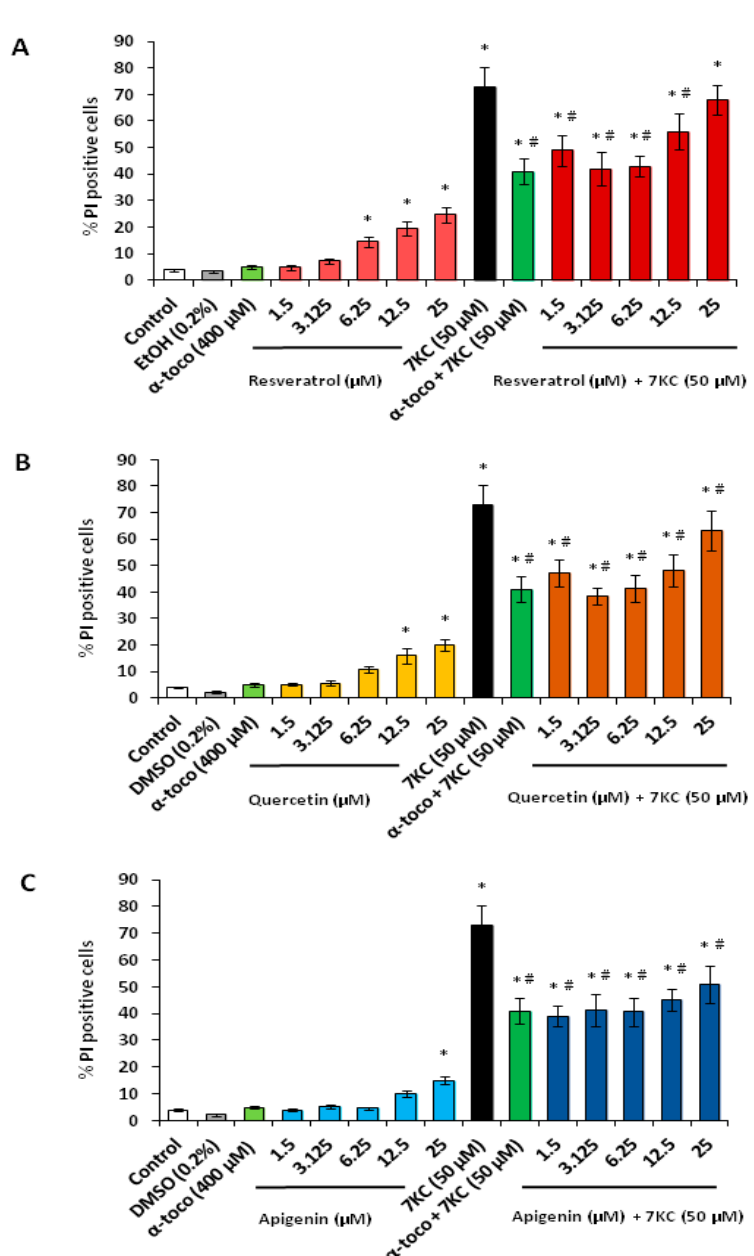
Figure 2. E ff ects of resveratrol, quercetin, apigenin or α -tocopherol on 7-ketocholesterol-induced plasma membrane permeability evaluated with propidium iodide. N2a cells were cultured for 48 h with or without 7-ketocholesterol (7KC, 50 µ M) in the presence or absence of α -tocopherol ( α -toco: 400 µ M) used as the positive control for cytoprotection, or with polyphenols: resveratrol (RSV) ( A ), quercetin (QCT) ( B ) or apigenin (API) ( C ) at concentrations ranging from 1.5625 (written 1.5) to 26 µ M. Plasma membrane permeability was measured by flow cytometry with propidium iodide (PI): for each assay, the percentage of PI positive cells was determined. Two vehicle controls were realized: Ethanol (EtOH) (0.2%) used with RSV and 7KC, and DMSO (0.2%) used with QCT and API. Each value is the mean ± standard deviation (SD) of four independent experiments. Significance of the di ff erences between control (untreated cells) and RSV-, QCT-, API-, α -toco- or 7KC-treated cells; Mann–Whitney test: * p < 0.05 or less. Significance of the di ff erences between 7KC-treated cells and (7KC + (RSV, QCT, API or α -toco))-treated cells; Mann–Whitney test: # p < 0.05 or less. No significant di ff erences were found between control and vehicle-treated cells (Ethanol (EtOH): 0.2% and DMSO: